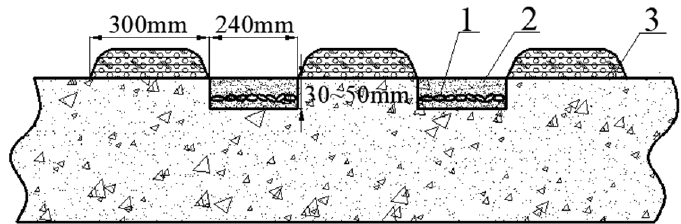
Figure 2. The agronomic pattern for wide-boundary sowing of wheat after rice. 1. Wheat seed. 2. “ no-straw ” seeding belt. 3. Straw belt.